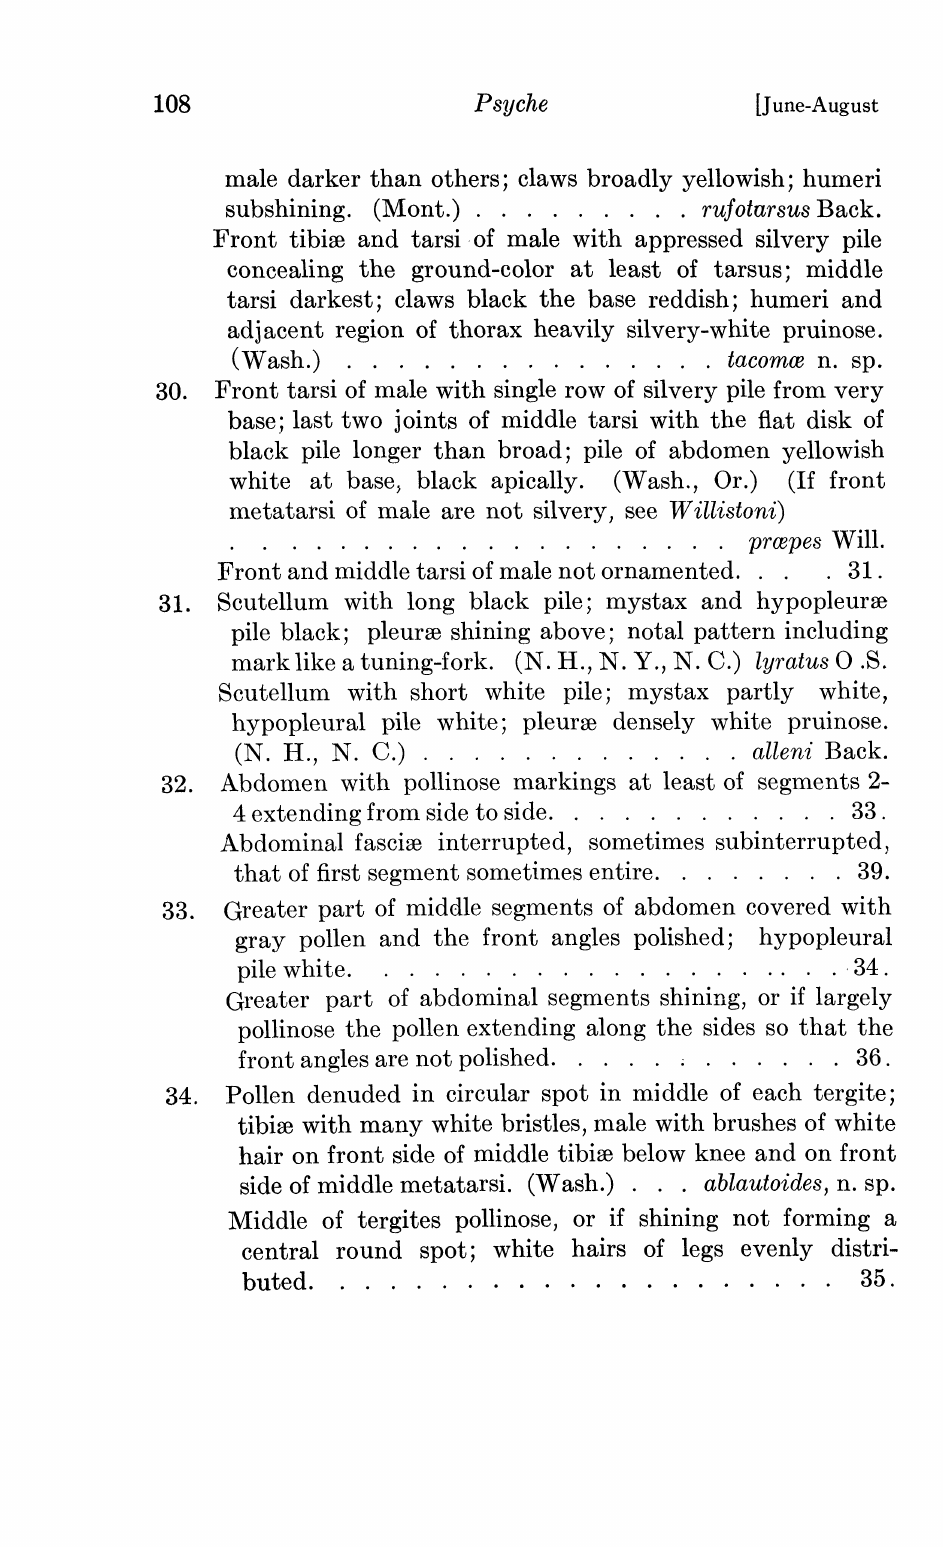
rufotarsus Back.